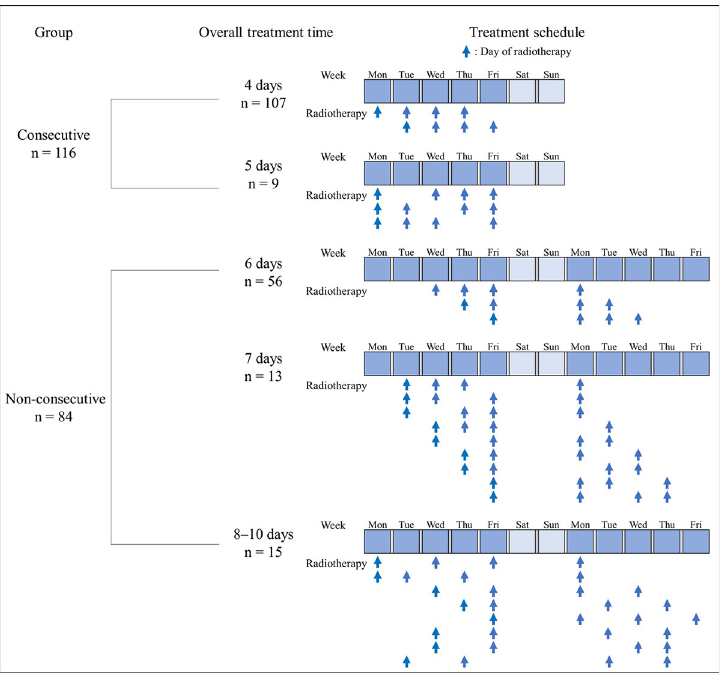
Fig 1. Graphical depiction of the stereotactic body radiotherapy schedules for the consecutive and non- consecutive treatment groups.